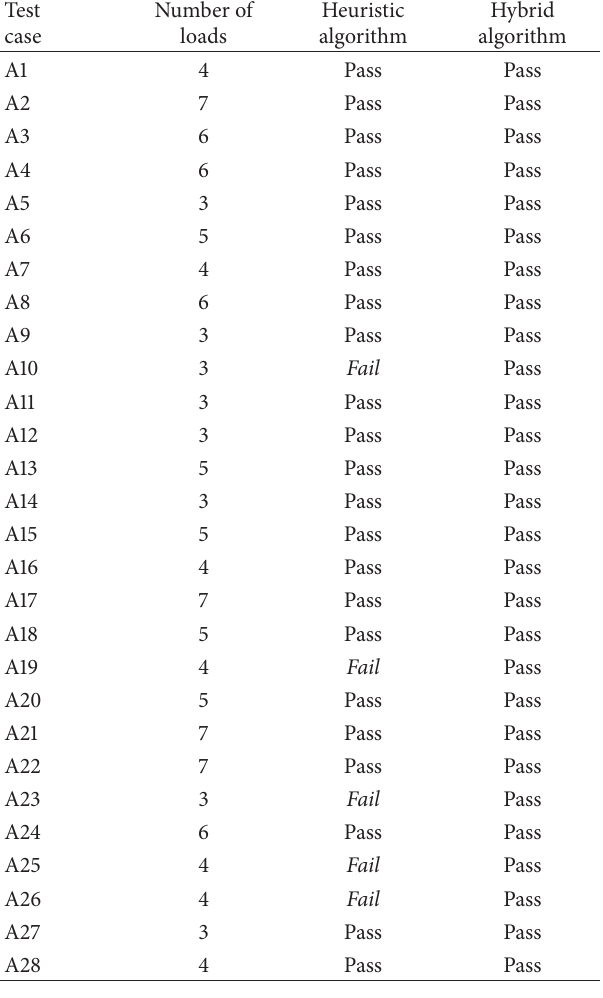
Table 5: Result of test cases